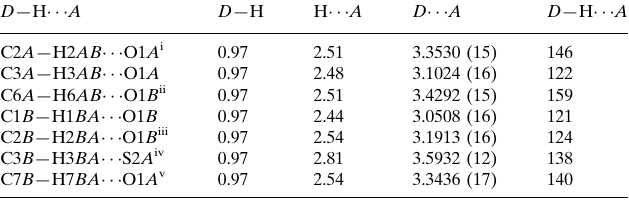
Hydrogen-bond geometry (A˚ , (cid:2)